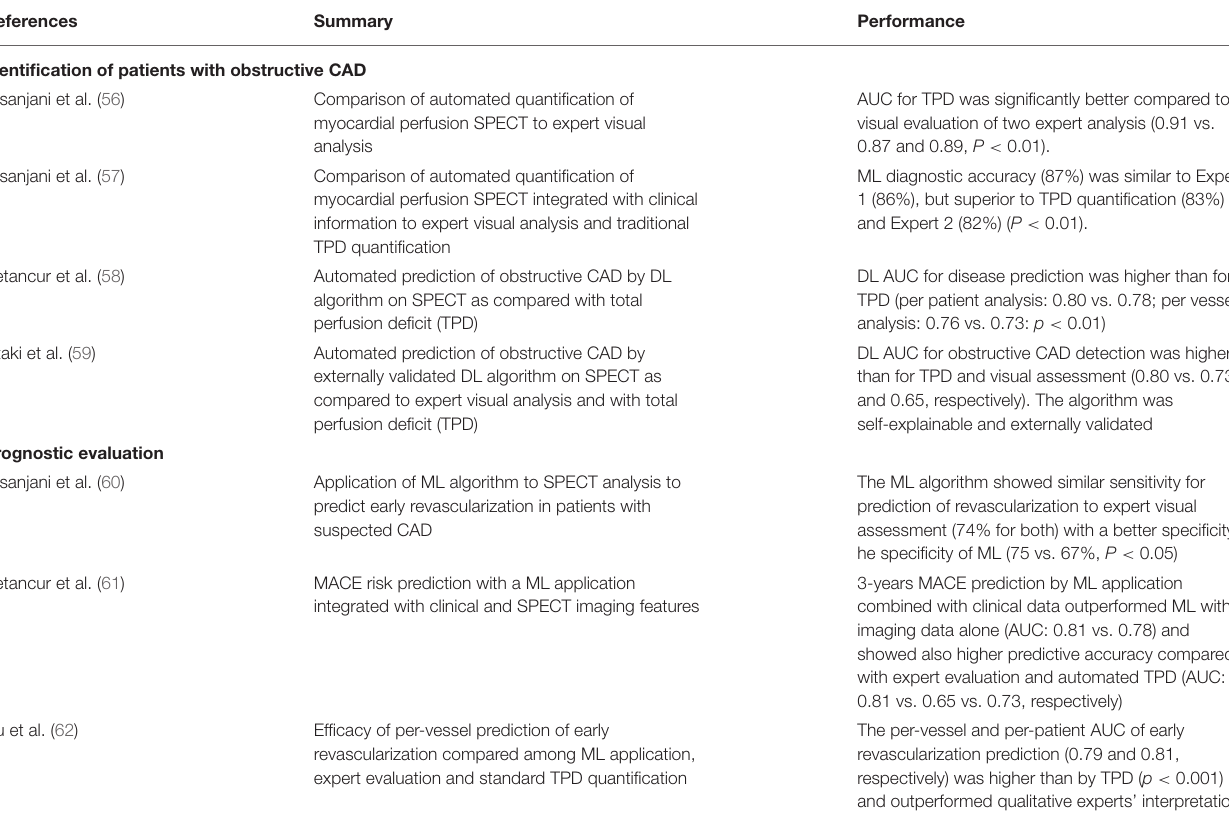
TABLE 4 | Main AI applications to nuclear imaging for the detection of